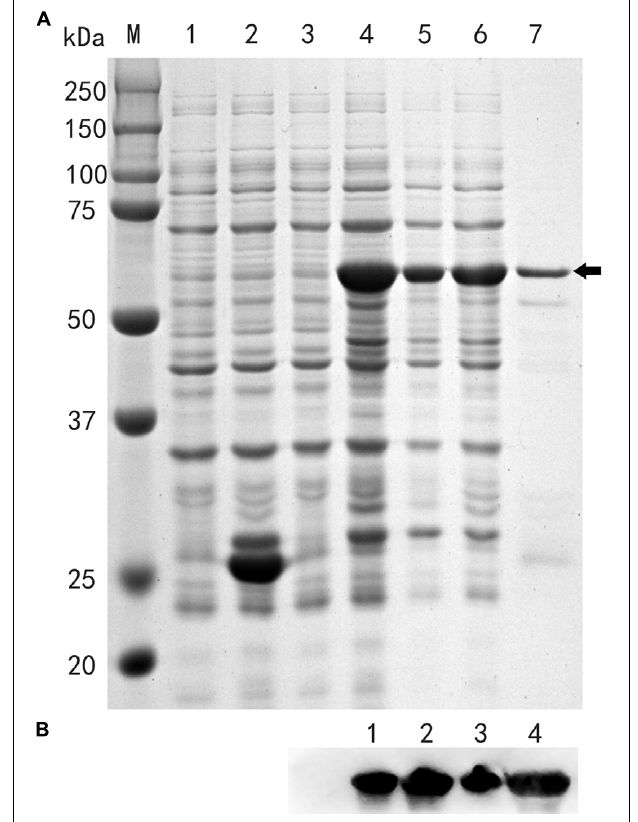
FIGURE 4 | Expression analyses of the TaFUSCA3 gene by real-time qRT-PCR. (A) mRNA relative expression index of TaFUSCA3 and TaSPA TFs. (B) Expression levels of the Ta1Bx7 gene encoding the SSP in developing endosperms from 4 to 32 DAP are shown, respectively. The Ta β -actin gene was used as an internal control for standardization. Error bars represent the SD for three technical replicates. Three biological experiments gave the same results. The Pearson correlation coefficient between the expression levels of TaFUSCA3 and TaSPA was 0.8670 and that between TaFUSCA3 and Ta1Bx7 was 0.8038.